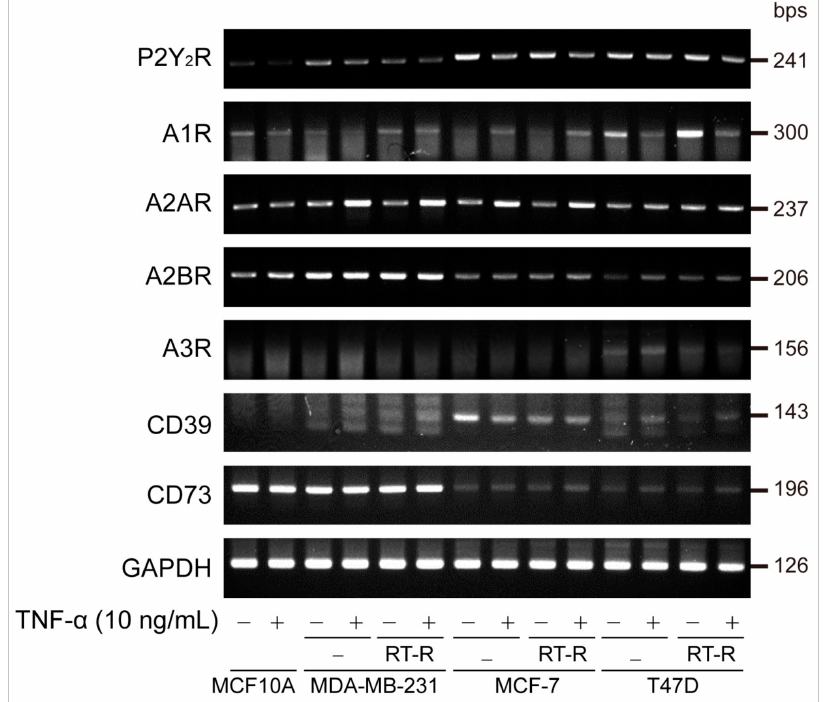
Figure 1. Expression levels of purinergic P2Y 2 receptor (P2Y 2 R), adenosine receptors (A1R, A2AR, A2BR, A3R), and ectonucleotidases (CD39, CD73) in various breast cancer (BC) cells and their radiotherapy-resistant (RT-R)-BC cells. Normal epithelial cell MCF-10A, triple-negative breast cancer cell (TNBC) MDA-MB231, non-TNBCs MCF-7 and T47D, and their RT-R-BC cells were treated with or without TNF- α for 24 h. Total RNA was collected from the cells, and P2Y 2 R, adenosine receptor (A1R, A2AR, A2BR, A3R), ectonucleotidases (CD39, CD73), and GAPDH mRNA expression levels were analyzed by RT-PCR as described in Section 2. Results were confirmed by repeated